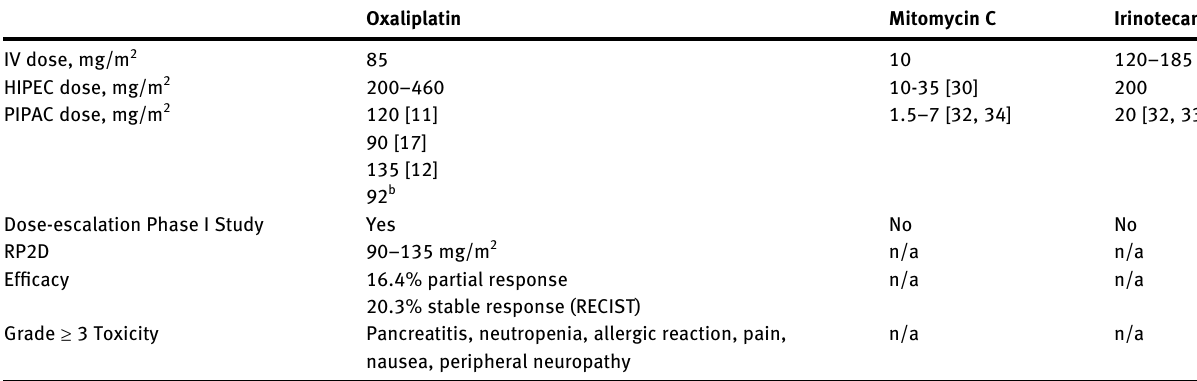
Table  : Summary of chemotherapeutic agents and their Phase I studies of their use in PIPAC for CRC patients with PM.